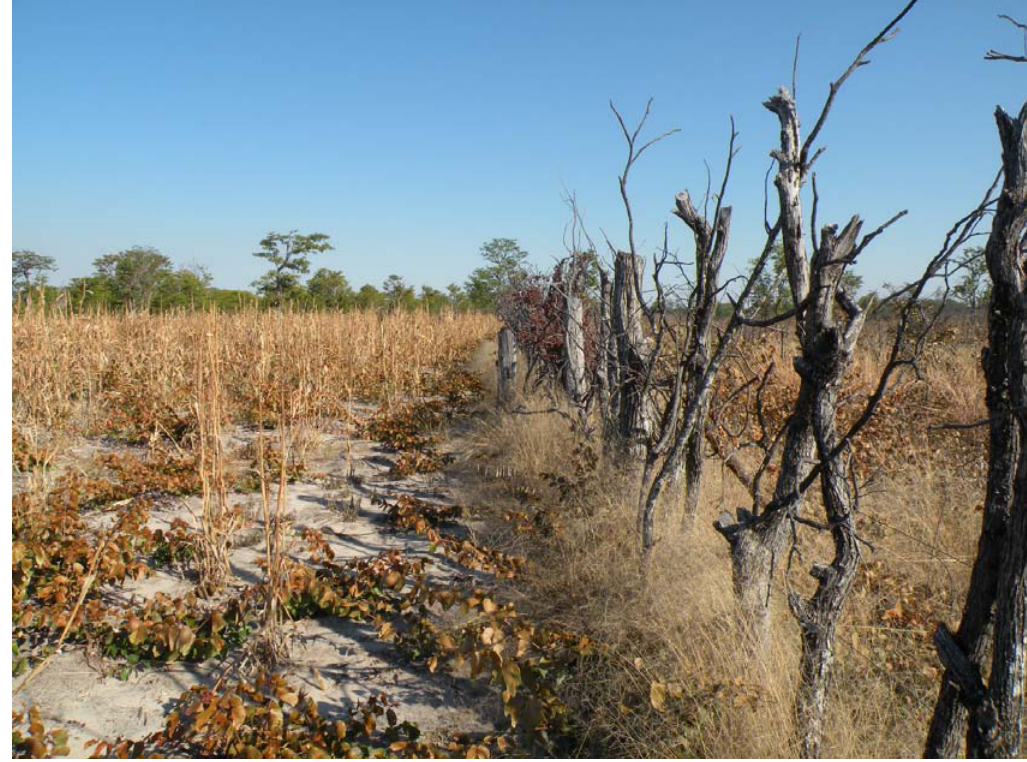
Figure 2. Combretum mopane [re]sprouting in an abandoned agricultural field in northwestern Botswana: The fence separates an abandoned agricultural area (on left) from open access where grazing and trampling may occur. Note the spread of c. mopane in the forefront. Photo by second